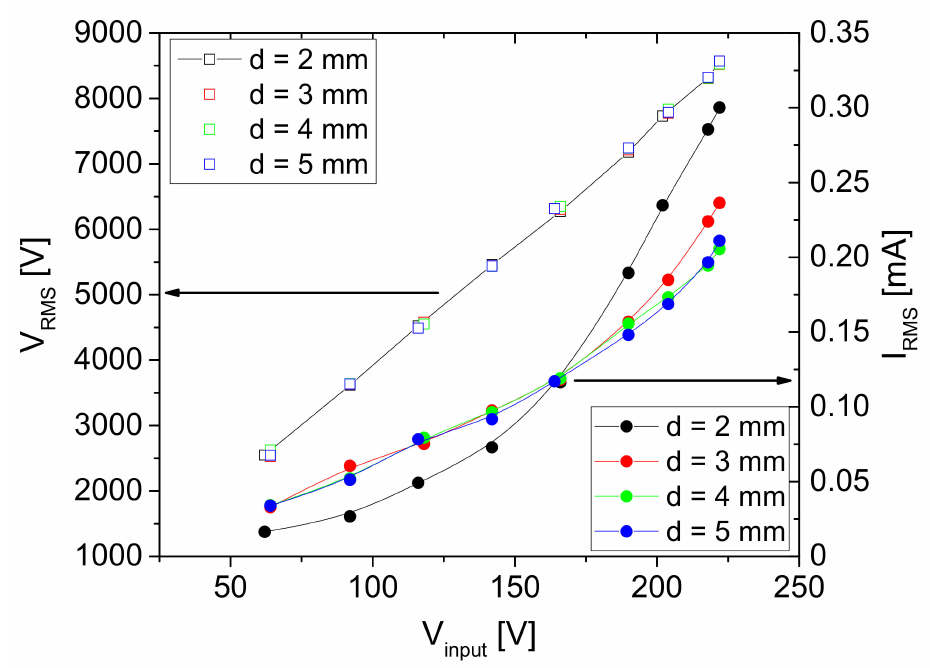
Figure 7. Dependence of the RMS voltage and current values on the input voltage V input for four geometries. The discharge was operating in